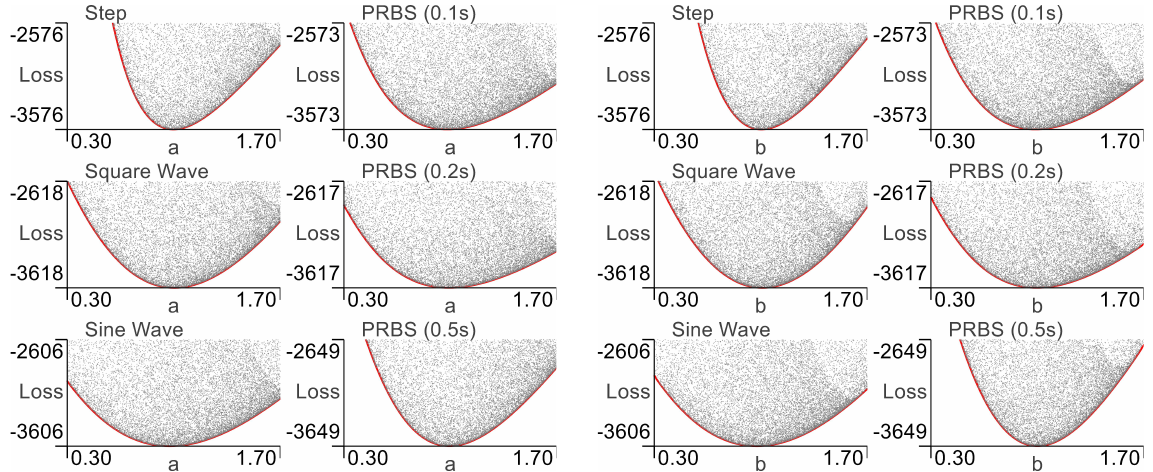
Figure 10: Exploratory analysis of the (cid:96) ( θ ) objective using the PL1 (red) and the URP (grey) methods. Results for parameter a (left) and b (right) show that both parameters are unambiguously identifiable for all six data-sets.